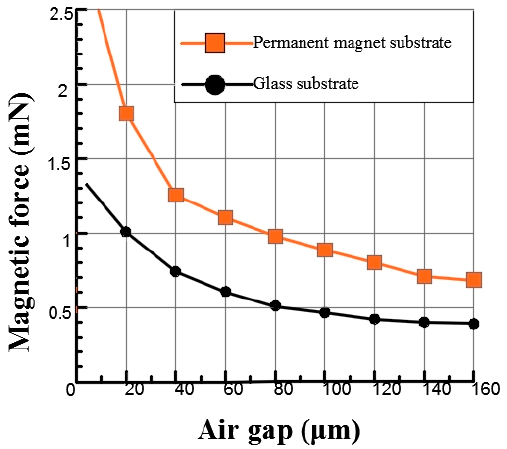
Figure 6. Variation of magnetic force with current on different substrates.